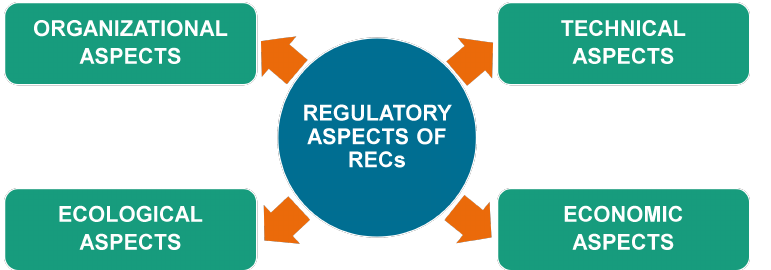
Figure 1. Aspects analyzed within this study following the PESTEL